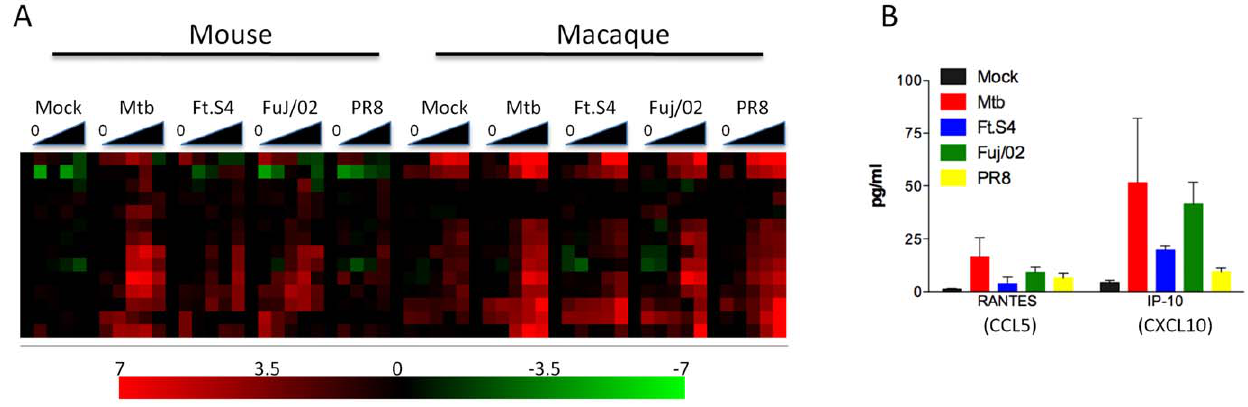
Figure 3. Mtb infection of AM induces robust activation of the interferon pathway. (A) Heatmap showing the expression profile of interferon response genes in murine and macaque AM exposed to the indicated pathogens. Infection with Mtb induces the most robust and sustained expression in both mouse and macaque. The scale represents fold change from time point 0 of 2 7– + 7 (log 2 ). (B) Luminex analysis of supernatants from murine AM exposed to the indicated pathogens demonstrating the production of the interferon induced chemokines, CCL5 and CXCL10 following Mtb infection. Results shown are the mean 6 SEM of 2–8 independent experiments. doi:10.1371/journal.pone.0022401.g003 PLoS ONE |